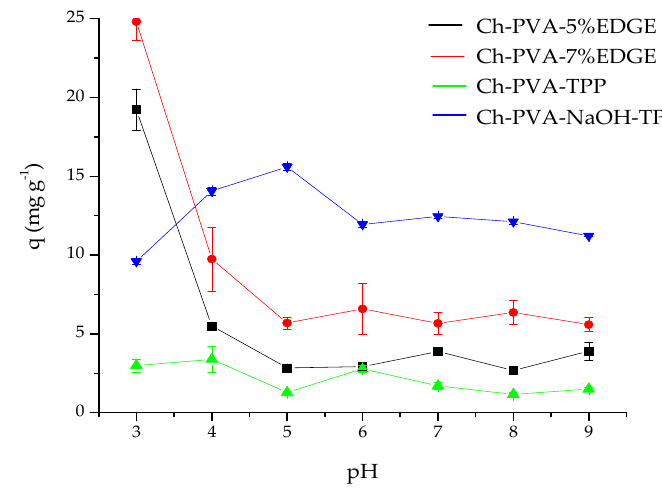
Figure 1. Effect of pH on the adsorption capacity of fluoride of synthesized materials: Q-PVA-5EGDE, Ch-PVA-7EGDE, Ch-PVA-NaOH-TPP, and Ch-PVA-TPP.